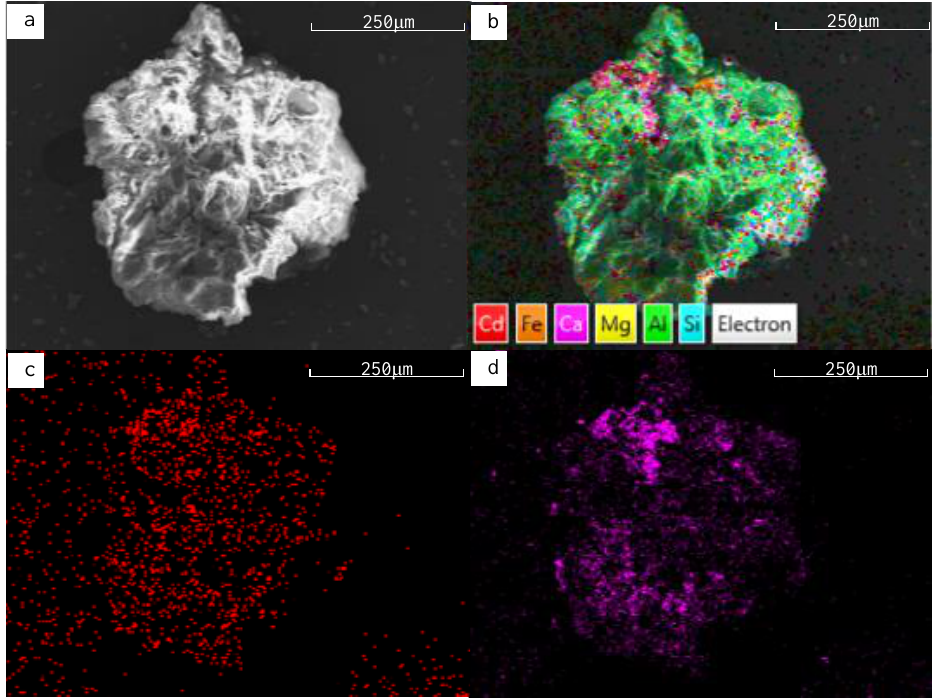
Figure 13. SEM of BFA-A after adsorbing Cd, ( a ) electron image, ( b ) EDS layered image, ( c ) Cd, ( d ) Ca.